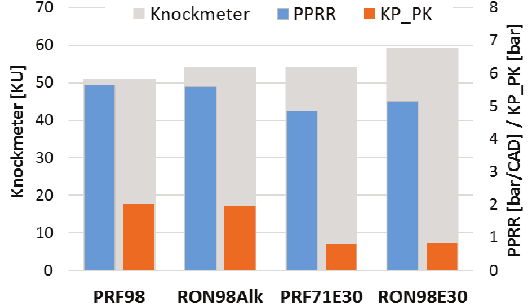
Fig. 9. Crankshaft angle position at 10% mass fraction burned (CA10), 50% (CA50), and the knock-point for all fuels at RON rating conditions